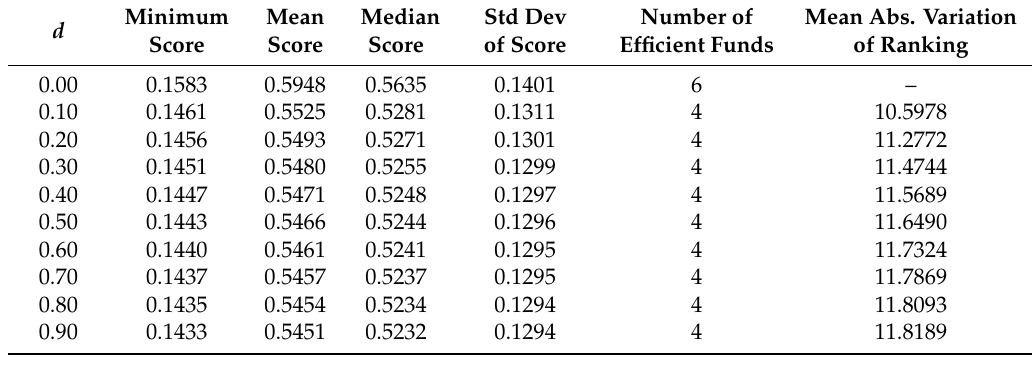
Table 14. Main results for AR restrictions in the case of asymmetric bounds and T = 7. Summary statistics on the performance scores (minimum, mean and median values, standard deviation), number of efficient funds and mean absolute variation (divided by 2) of the ranking positions.